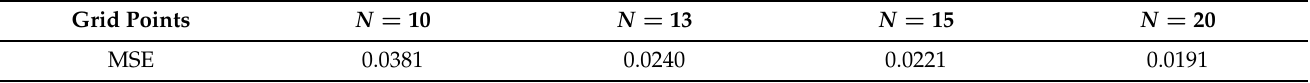
Table 4. The corresponding MSE values with M = 10 antennas and a different number of grid points. Grid